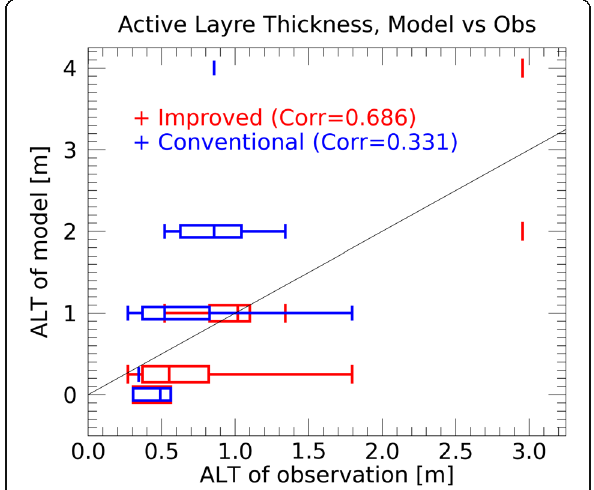
Fig. 5 Active layer thickness for model results (vertical axis) versus observed ALT values (horizontal axis). The results of the improved (red) and conventional (blue) schemes are shown. The box and whisker plot indicates the minimum, lower quartile, median, upper quartile, and maximum values of observation. The correlation coefficients for the relationship between the model results and the observed data are also